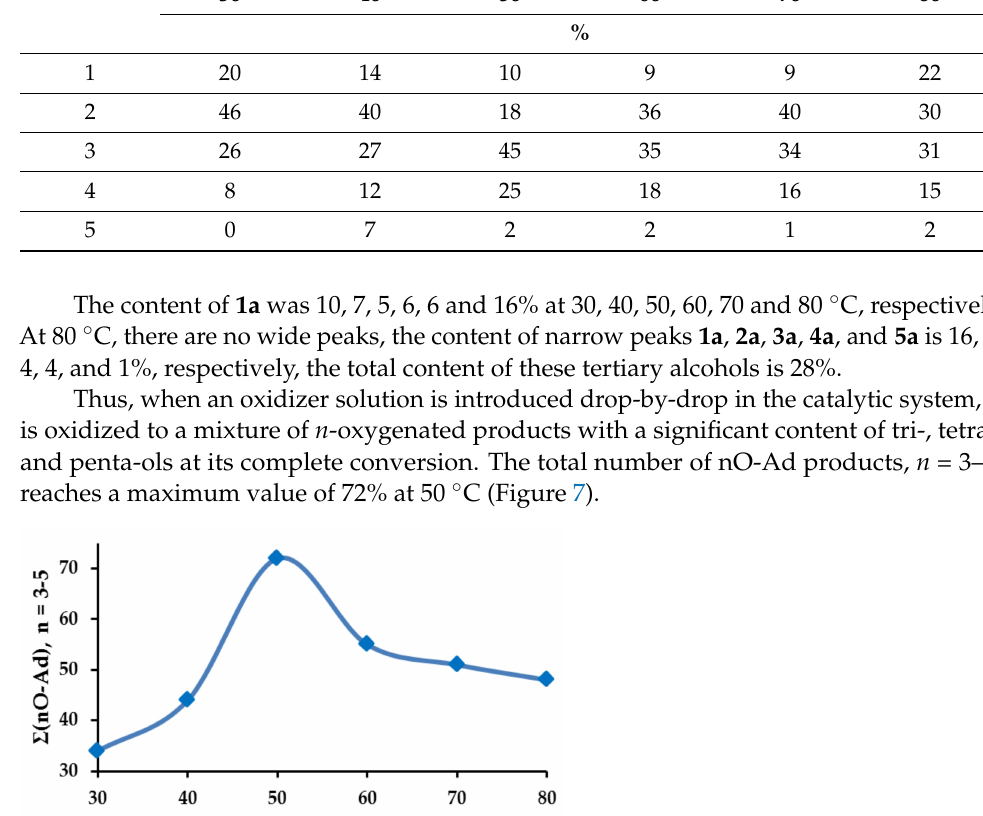
Table 1. The total yields of the five product groups nO-Ad, n = 1–5, at different reaction temperatures T. n